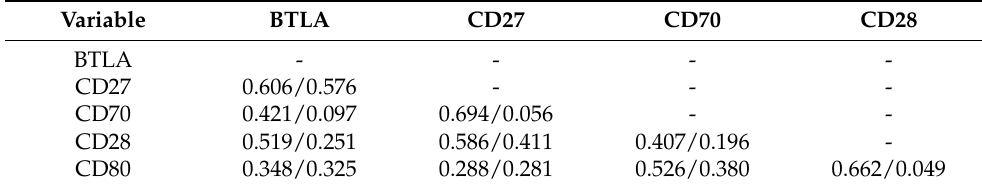
Spearman’s rank correlation was used to calculate correlations between serum con- centrations of the proteins studied and age, menopausal status and BMI. No high positive